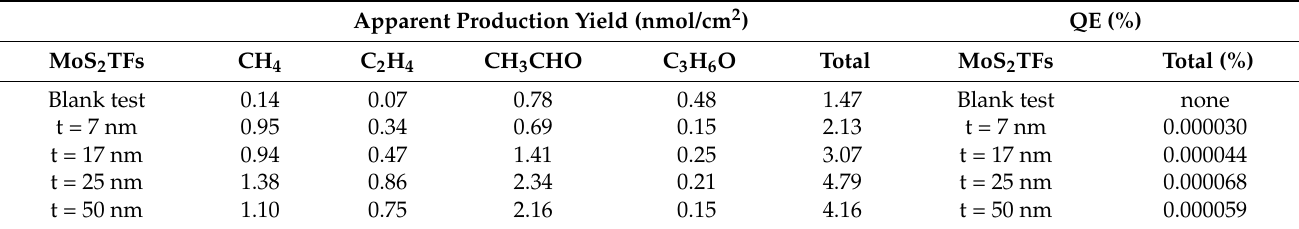
Table 3. Production yields and QEs of MoS 2 TFs with various